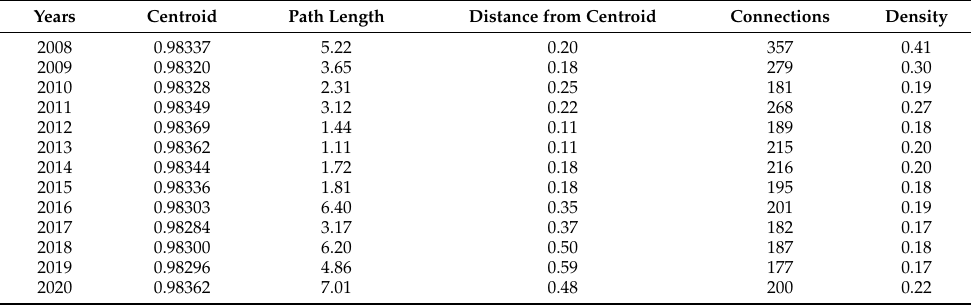
Table A1. Annual Network Properties explaining competition for Indian